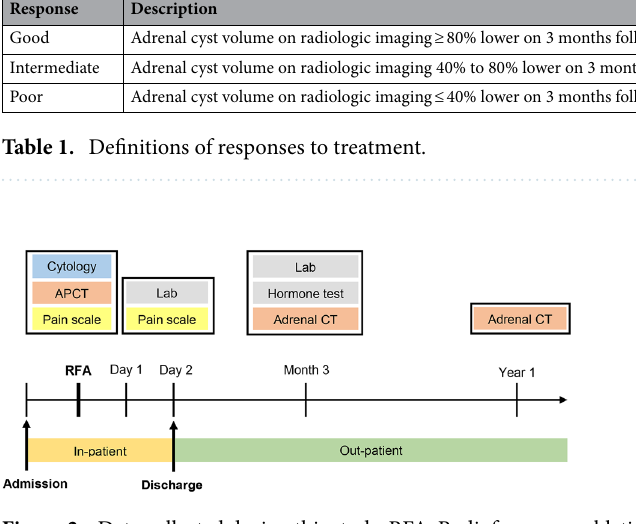
Figure 2. Data collected during this study. RFA, Radiofrequency ablation; APCT, Abdomino-pelvic computed tomography; Lab, Laboratory evaluation; Adrenal CT, Adrenal computed